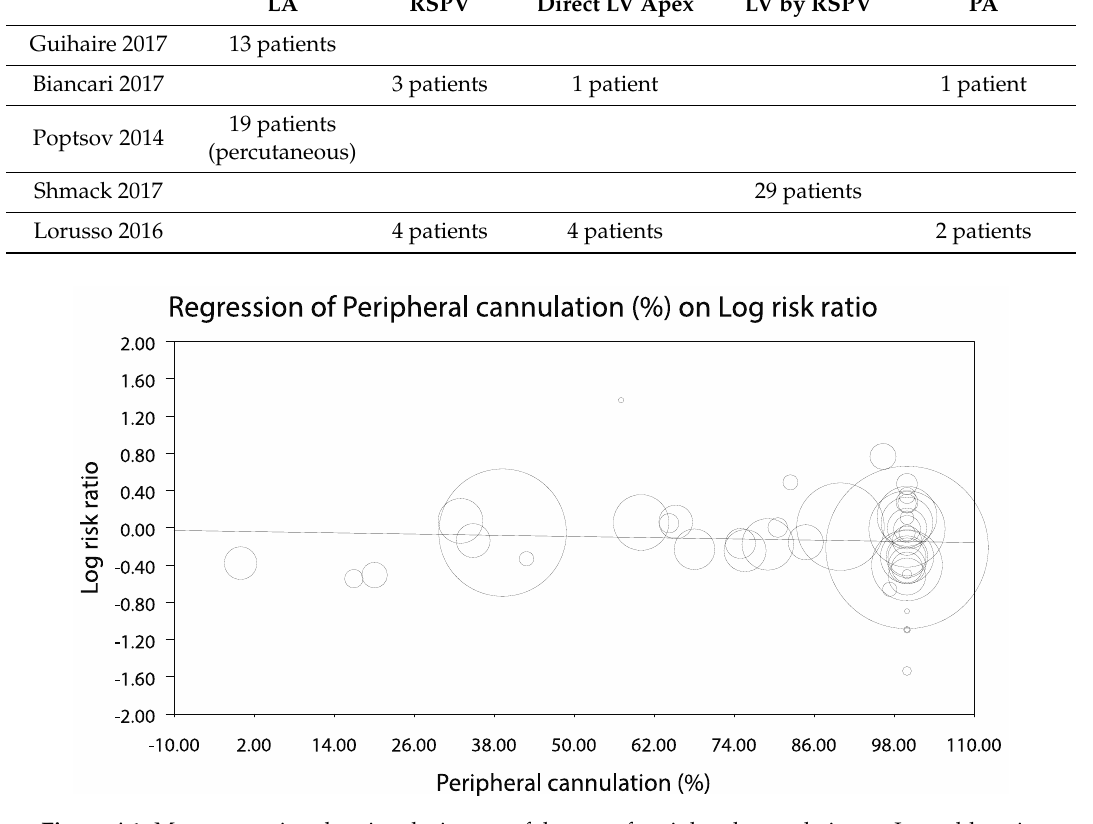
Table A5. LV unloading strategy.